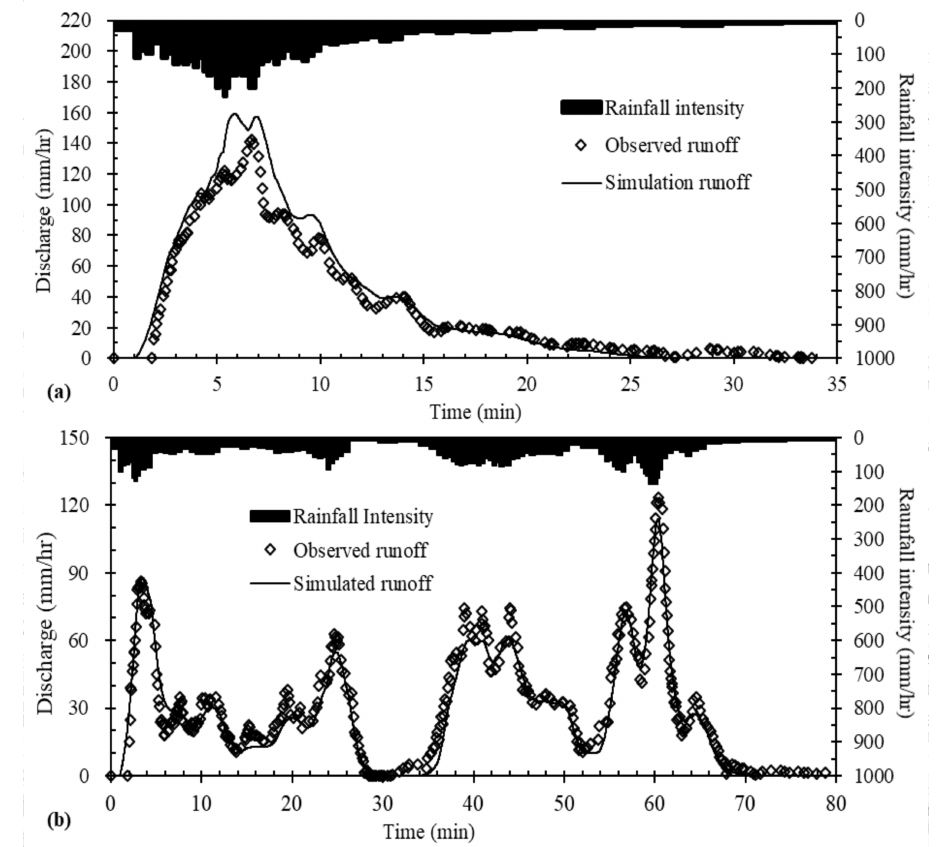
Figure 3. Comparison of simulated and observed hydrographs of two events on ( a ) 24 August and ( b ) 4 September,